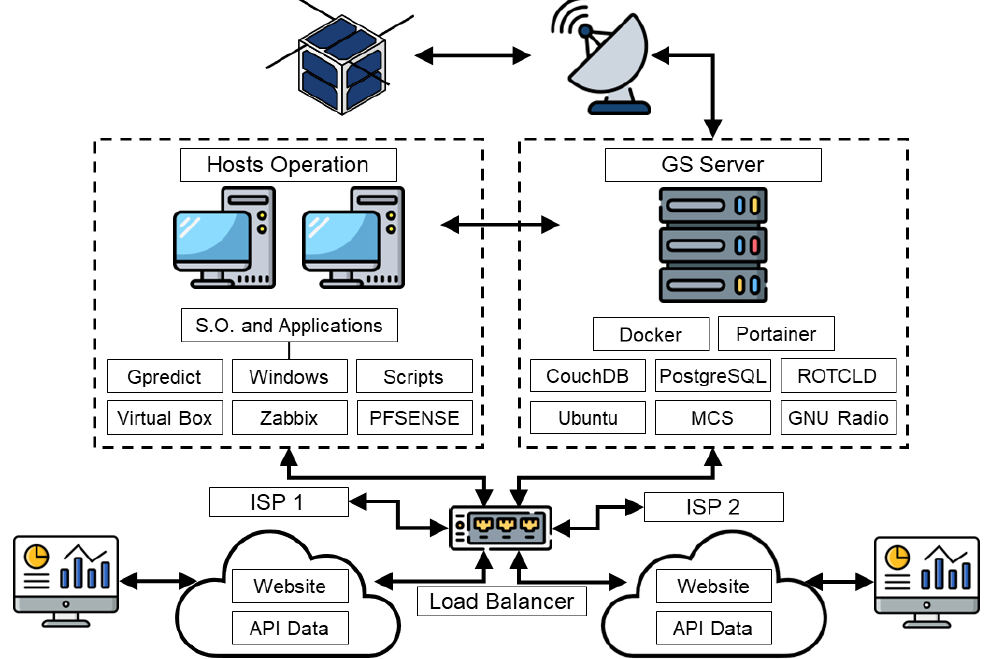
Figure 6. Ground station